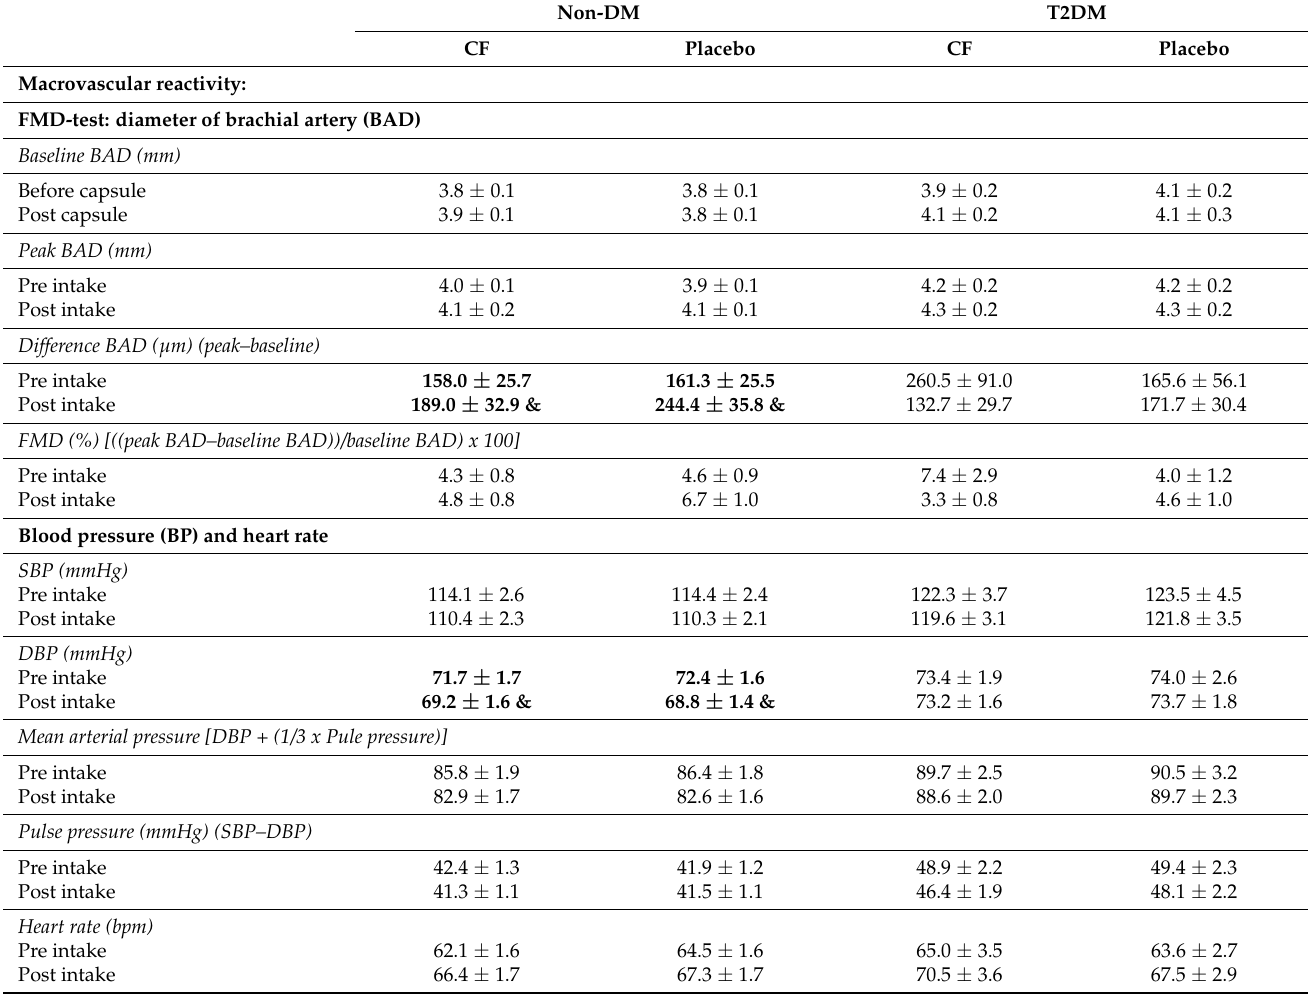
Table 4. Results of examinations for macrovascular